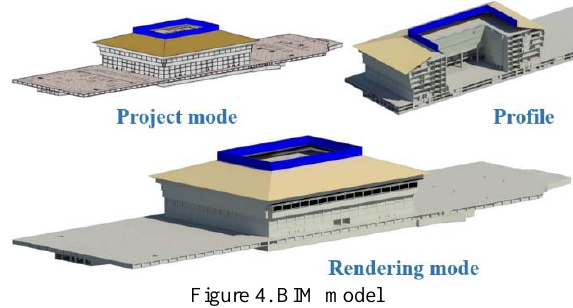
Figure 4. BIM model